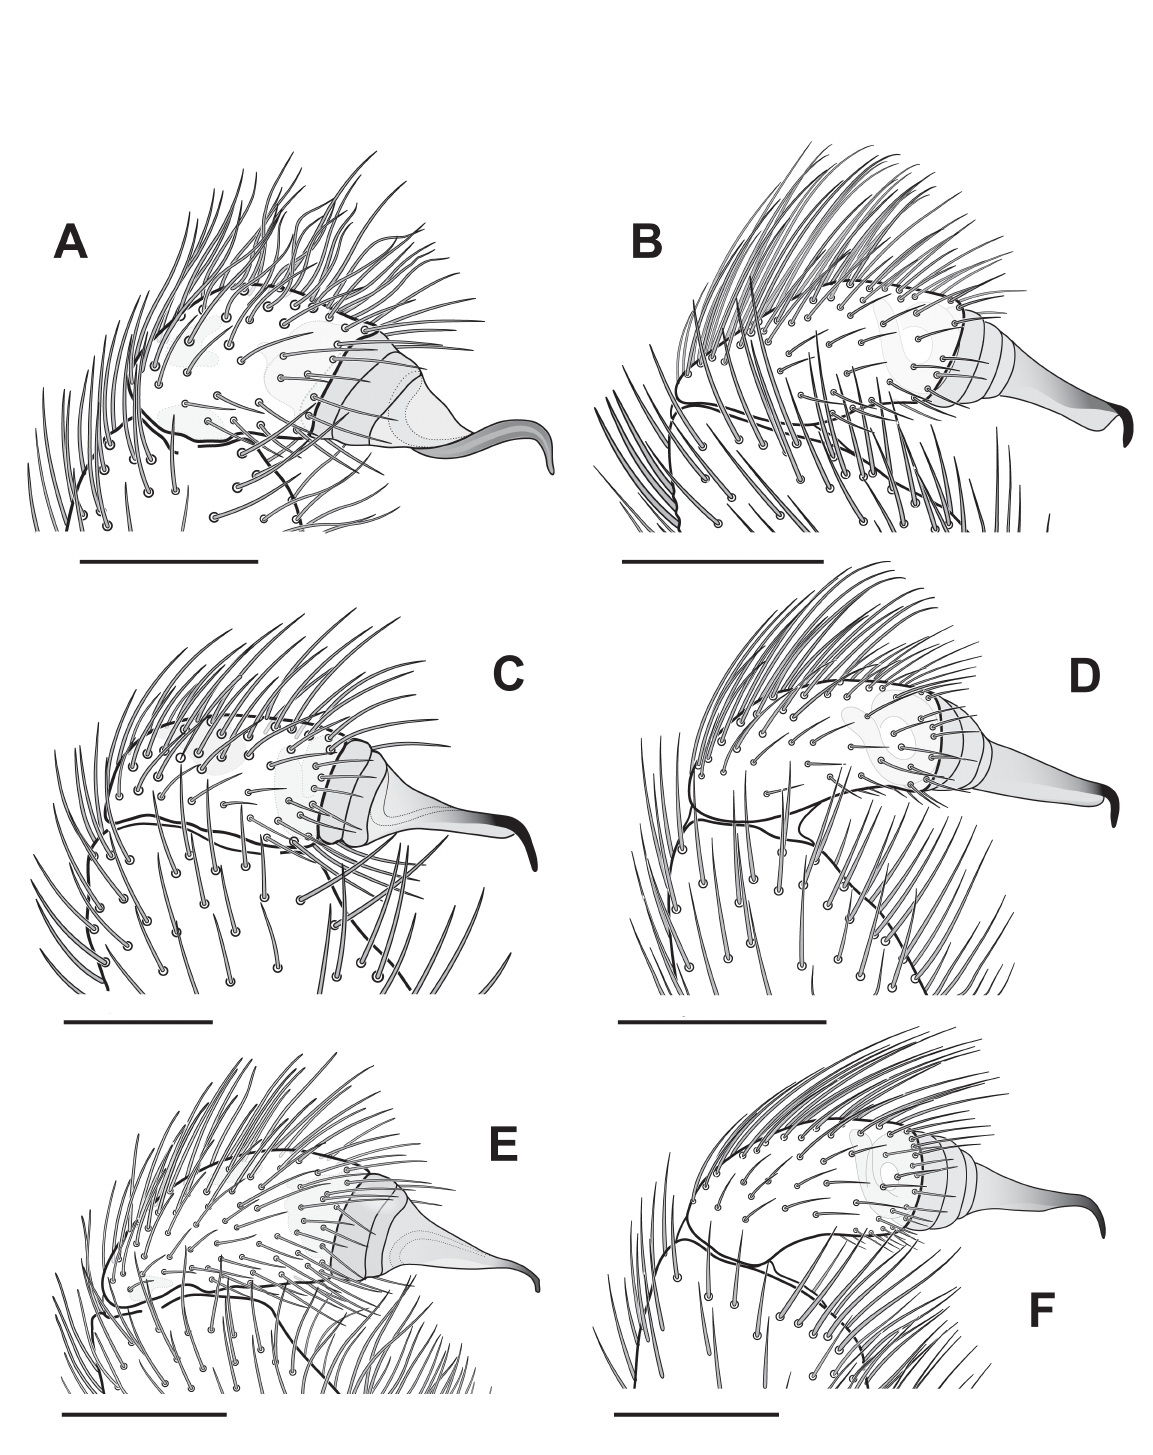
Fig. 44. Male copulatory organs of Zaitunia species, retrolateral. A . Z. spinimana sp. nov. (holotype). B . Z. beshkentica (Andreeva & Tyshchenko, 1969) (Babatagh). C . Z. psammodroma sp. nov. (holotype). D . Z. wunderlichi sp. nov. (holotype). E . Z. ferghanensis sp. nov. (paratype). F . Z. maracandica (Charitonov, 1946) (Ulus). Scale bars = 0.2